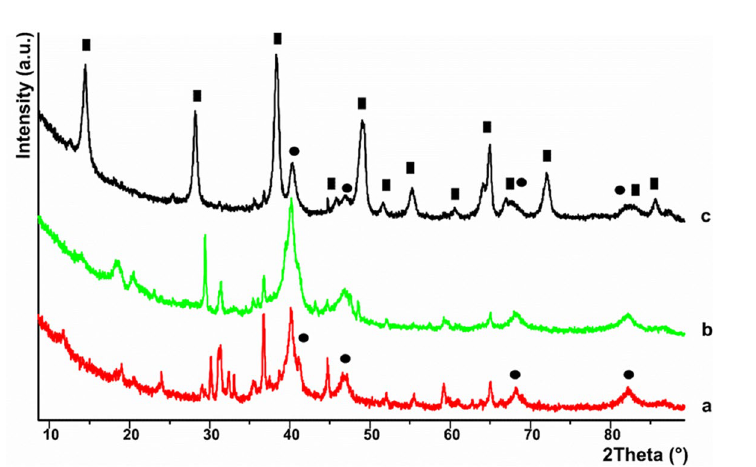
Figure 2. FESEM images of the 1 at different magnifications.